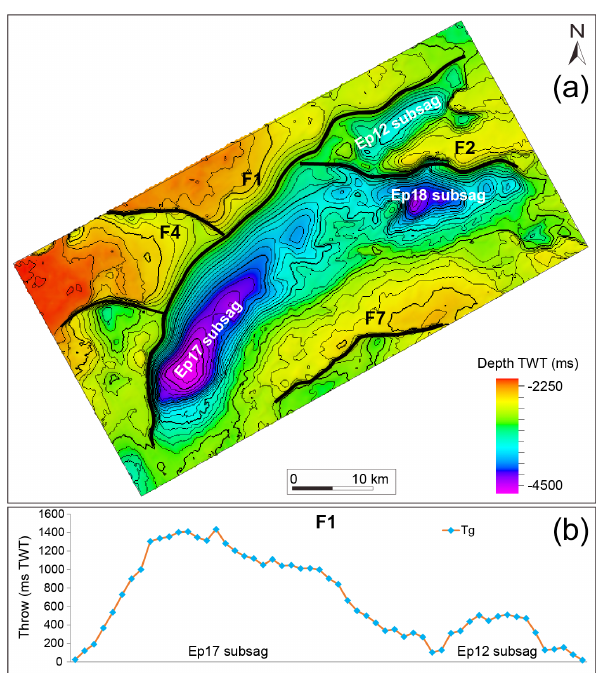
Figure 7. Panel (a) is the TWT structure map of the top basement showing the location of key fault traces and sub-sags. The colour bar shows the depth of the top basement from the ground. Red is the uplift, and purple is the depocentre. Panel (b) shows the T – x plots of the major fault F1.